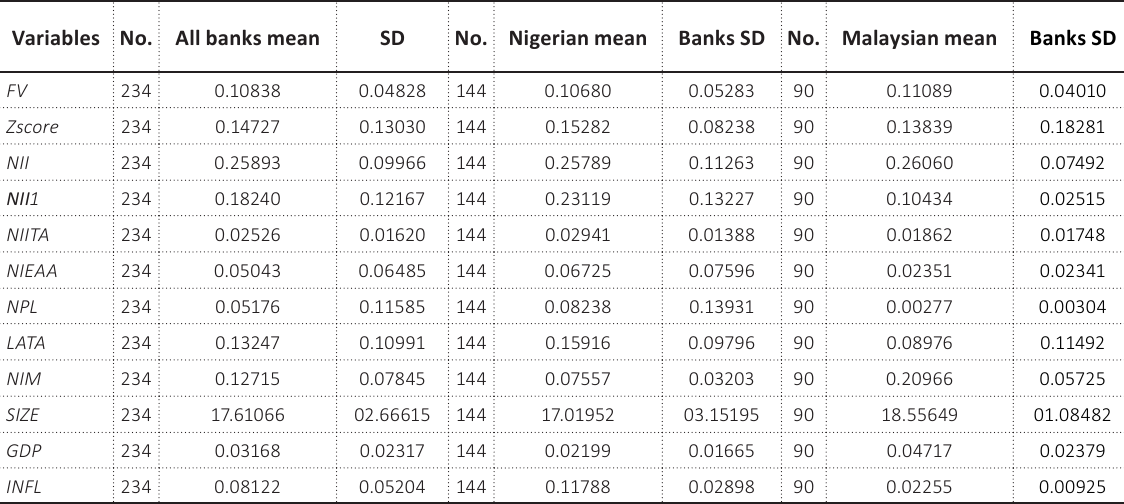
Table 1. Summary of descriptive statistics